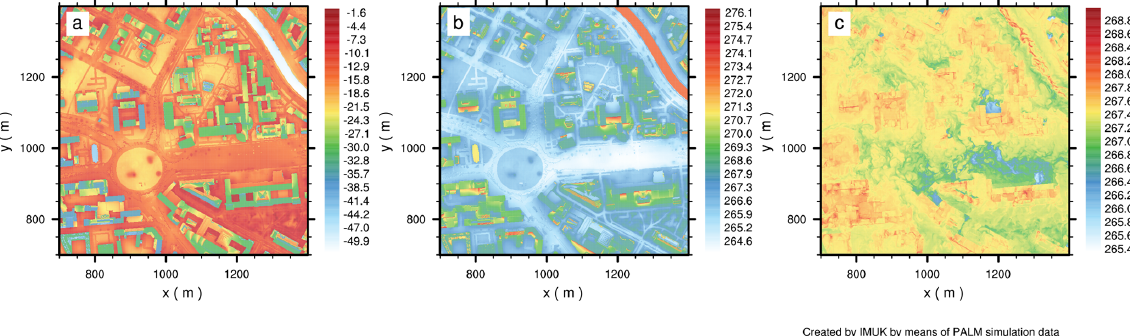
Figure 17. The x – y cross section of (a) surface net radiation (Wm − 2 ), (b) surface temperature (K) and (c) 2m potential temperature (K) for a nested simulation with 1m grid resolution for a winter scenario at 18 January 2017, 00:00UTC, for an area around Ernst-Reuter-Platz in Berlin, Germany. The displayed area is the same as in Fig.